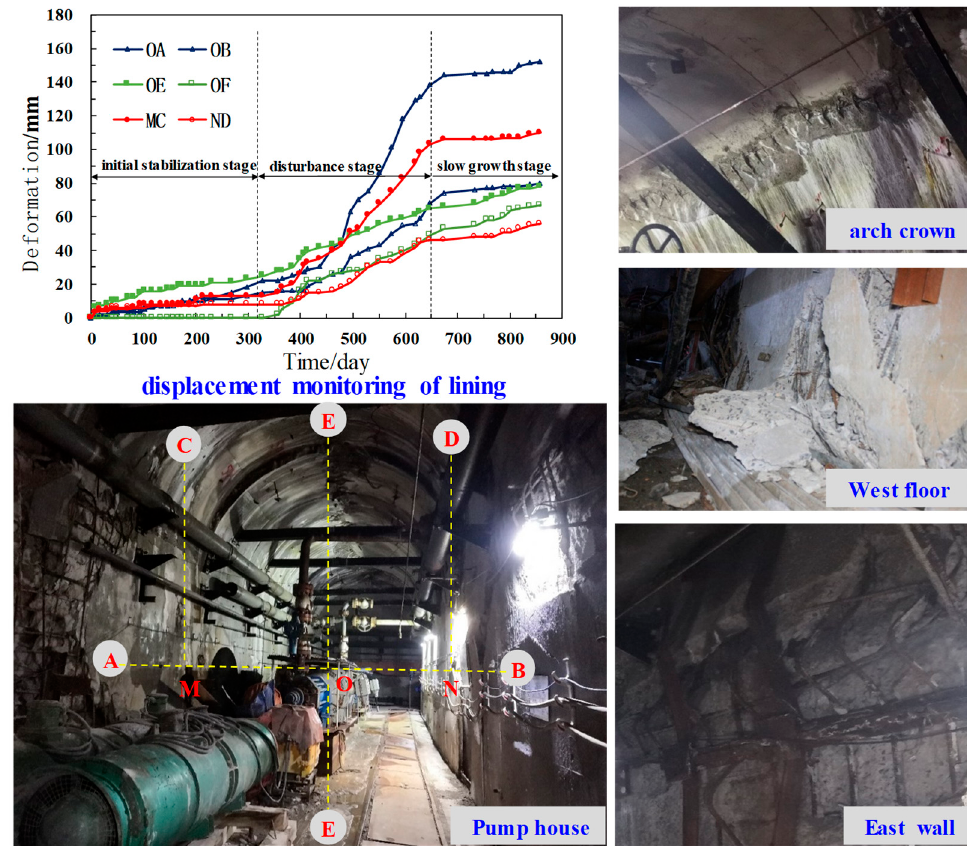
Figure 3. The displacement curve and on-site damage.